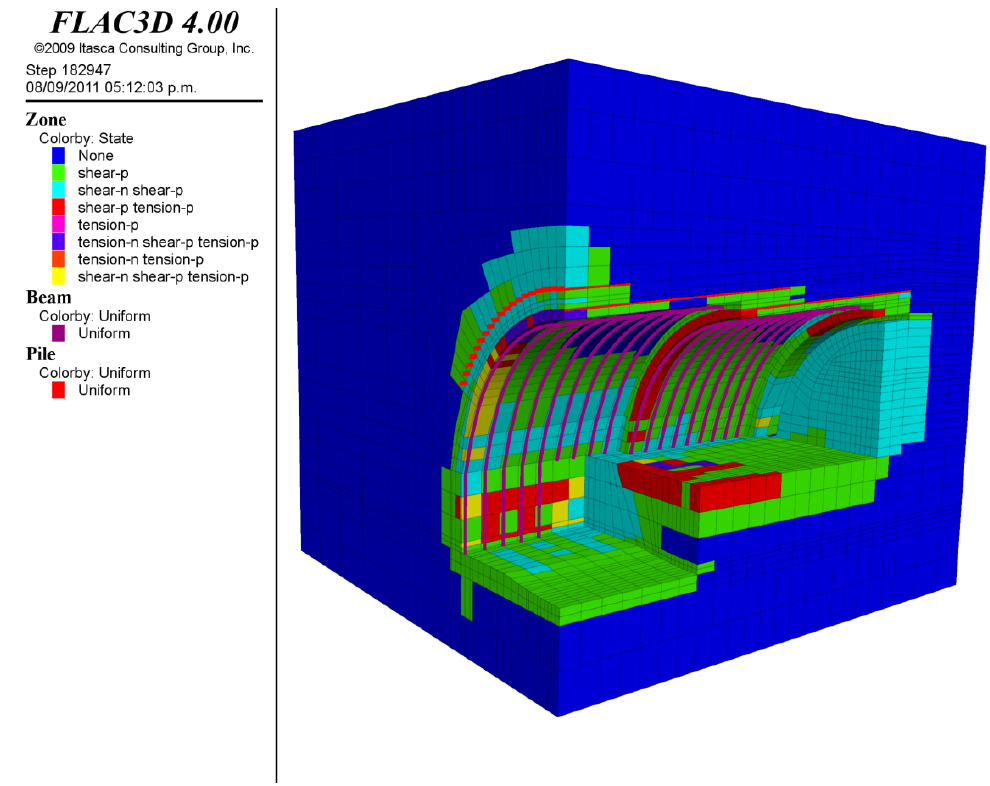
Figure 11. States of plasticization in an intermediate stage of the excavation. Minimum parameters [12].